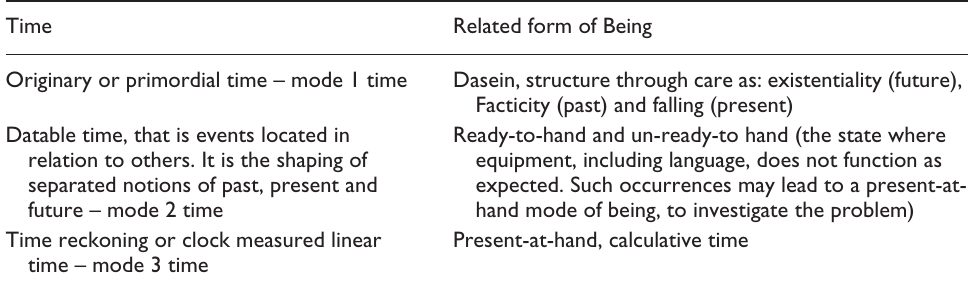
Table 1. Heidegger notions of time and being. Time Related form of Being Originary or primordial time – mode 1